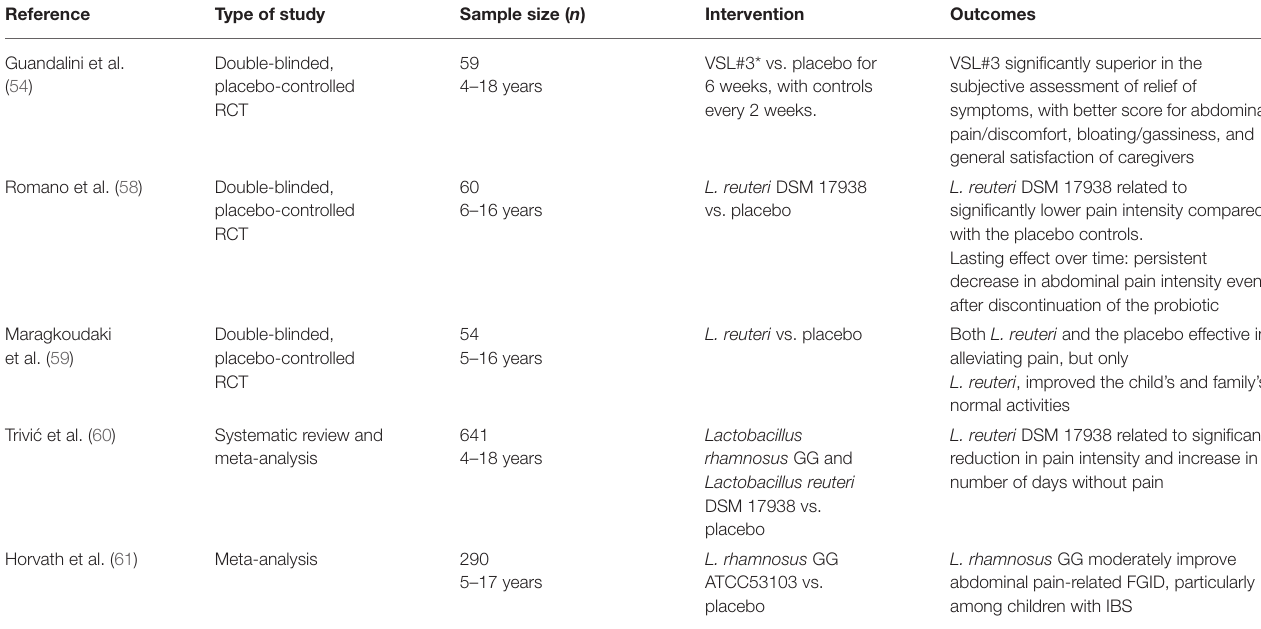
TABLE 2 | Irritable bowel